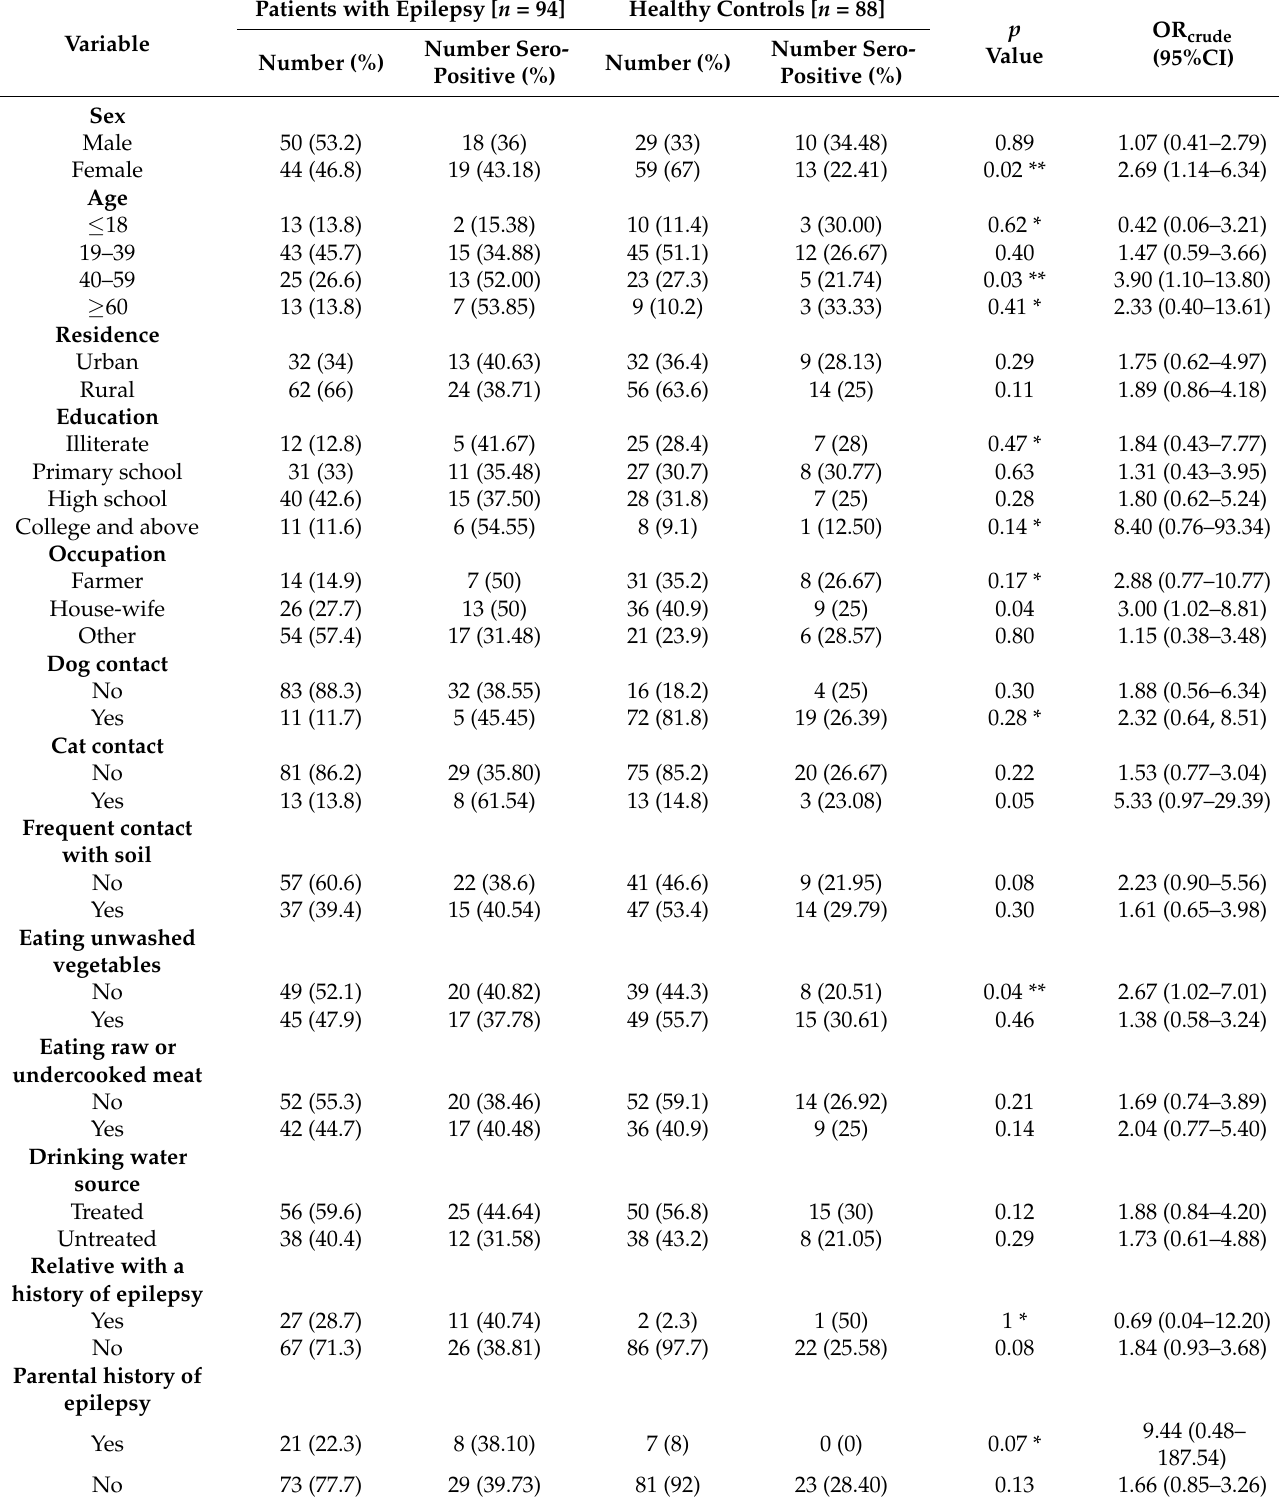
Table 1. Toxocara seropositivity in epileptic patients and healthy people (control group) according to sociodemographic characteristics subjected to analysis using the Pearson’s chi-square